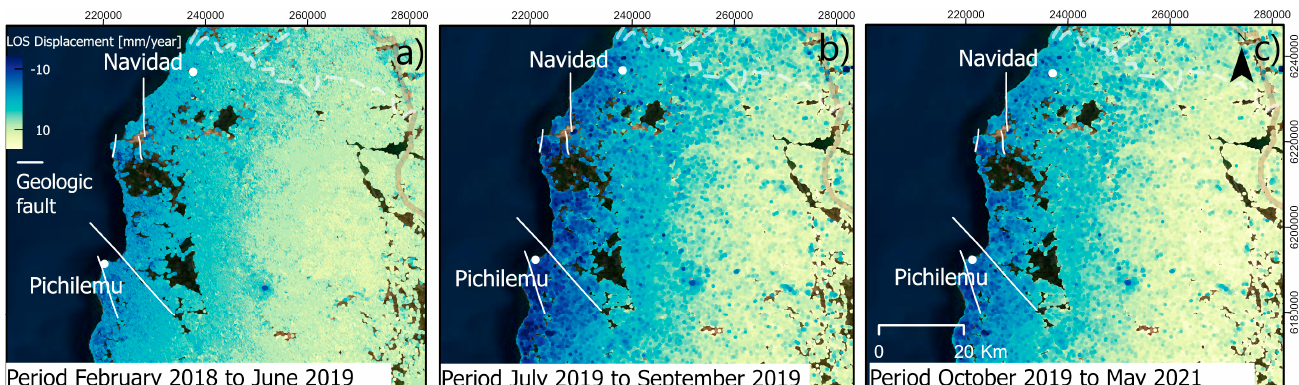
Figure 11. Geological map of the study area for Navidad and Pichilemu, with main lithology [56], black segmented lines for geological faults [53] denominated 1,2, and 3 for the areas of Navidad and Pichilemu, and blue lines denoting urban infrastructure for the study area.